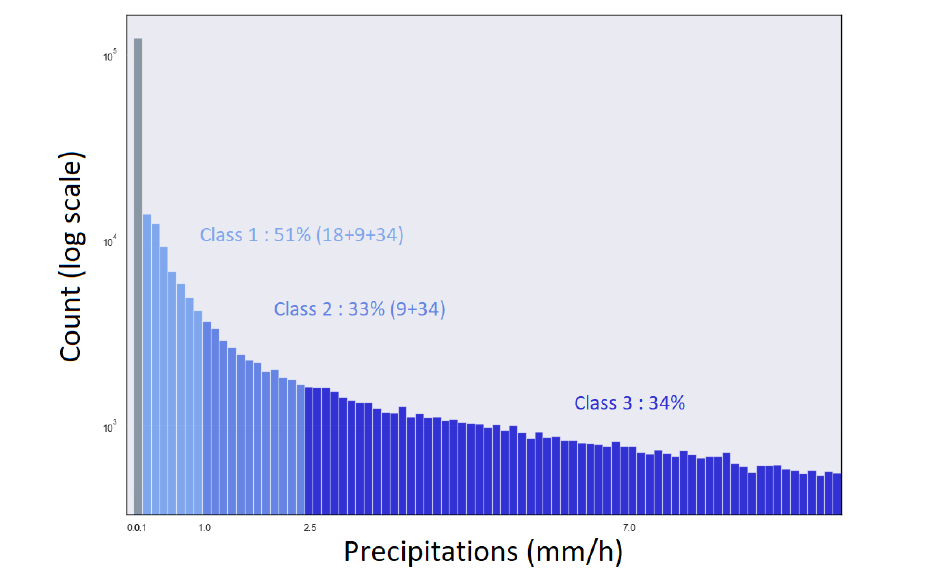
Figure 4. Histogram of maximal CRF over the study area calculated on the training base and represented in log scale. The percentages correspond to the proportion of maxima belonging to each